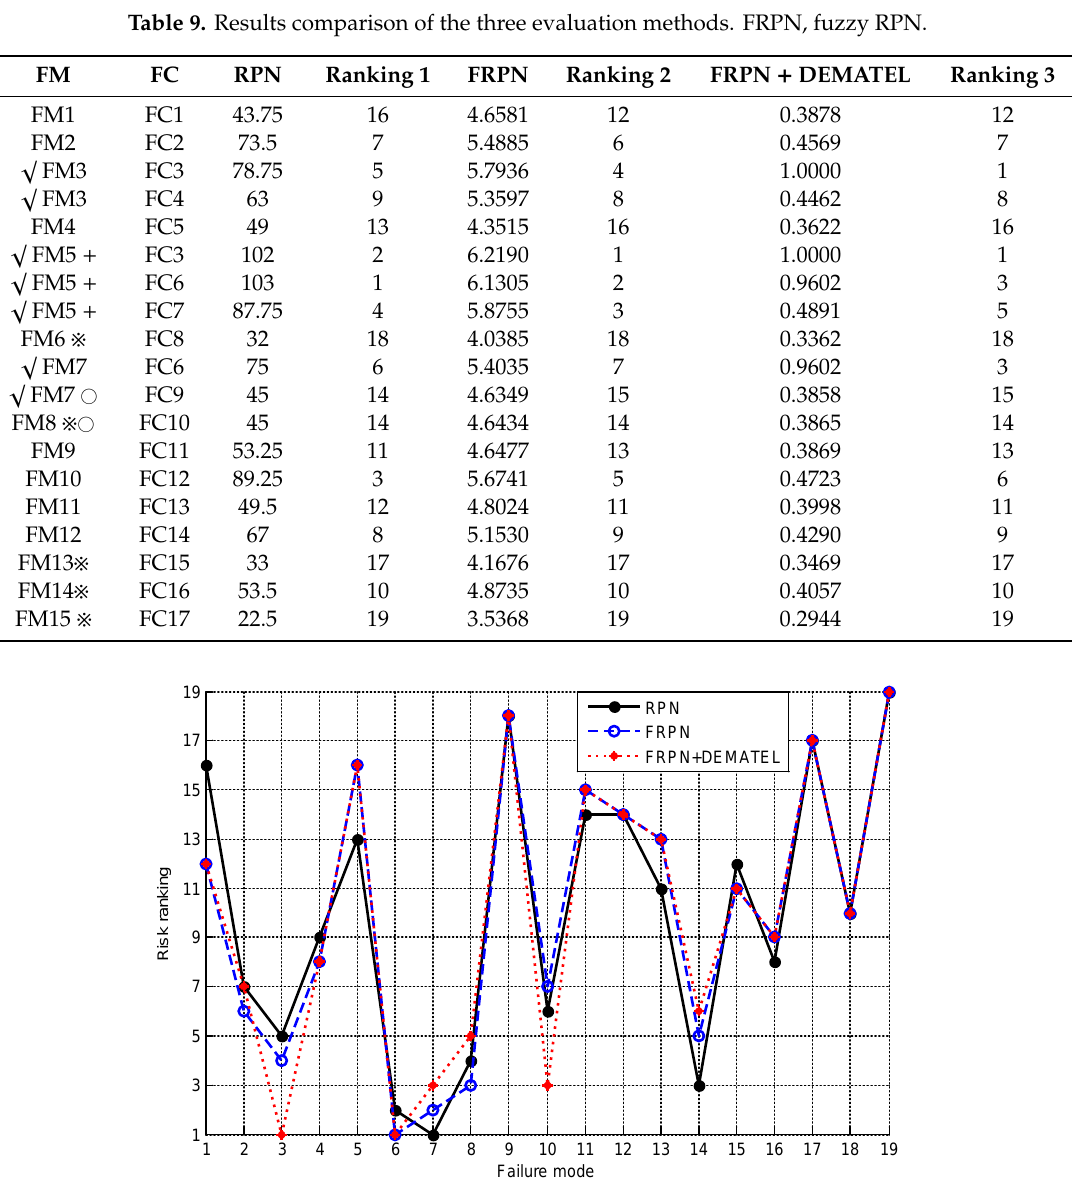
Figure 4. Risk ranking of failure modes for the propulsion subsystem.